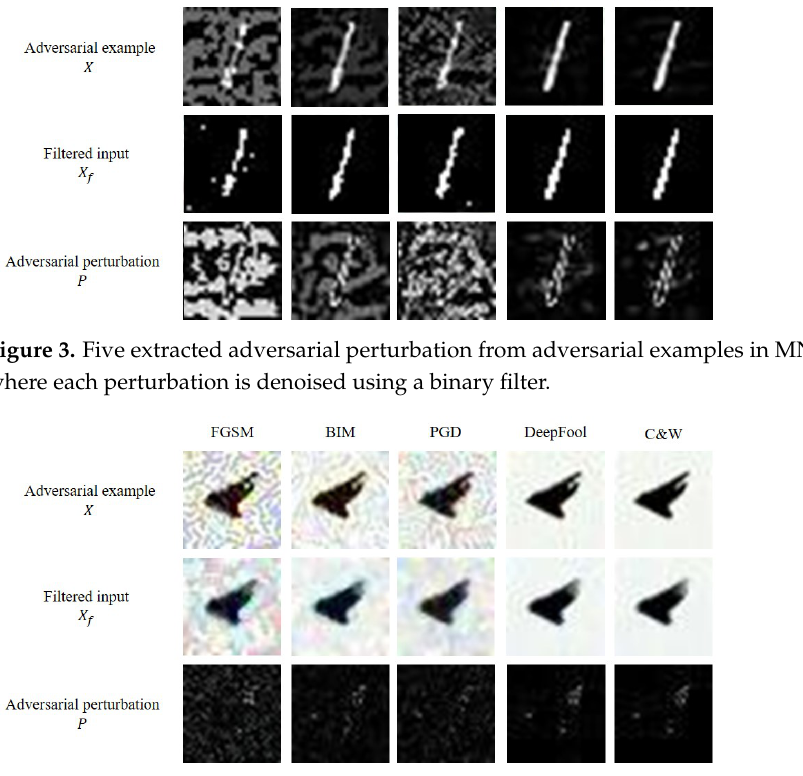
Figure 4. Five extracted adversarial perturbations from adversarial examples in CIFAR-10 test dataset, where each perturbation is denoised using a median